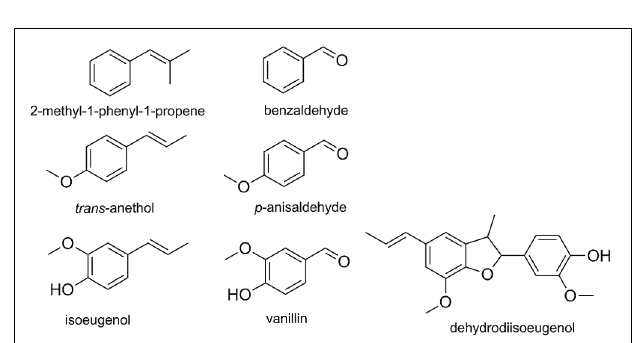
the first 30 min of the reaction accounts for lower accuracy in the quantification, resulting in an apparent non-continuous time profile.